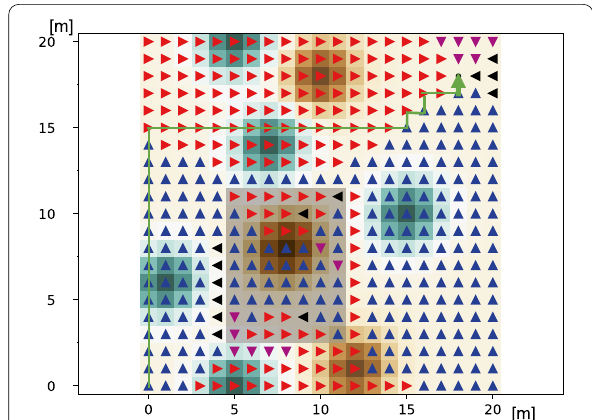
Fig. 10 The case of the more attractive goal ( w 1 , w 2 ) = ( 1,0 ) . The hopper find the path from the start to the goal, which passes on the